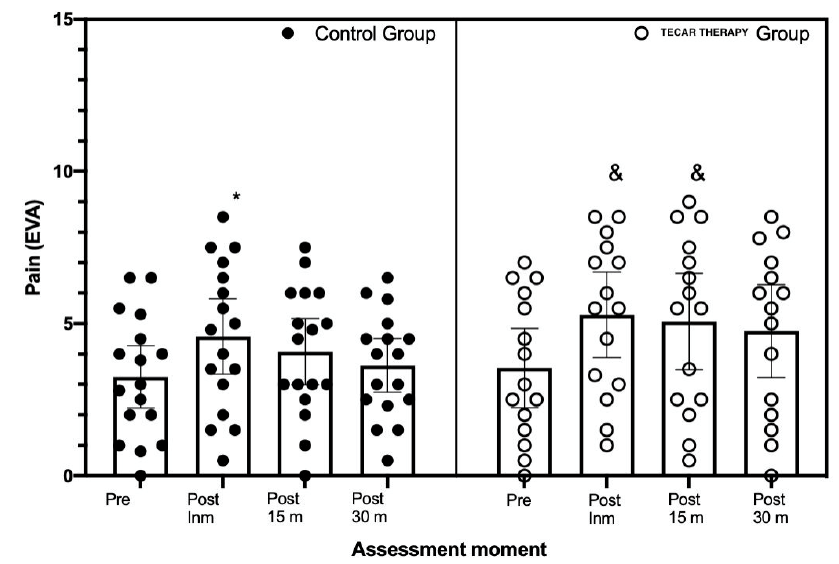
Figure 7. Mean, minimum, and maximum values of muscle temperature (°C) in the two intervention groups in relation to the measurements taken (i.e., Pre, post-immediate, post-15 min, and post-30 min). Note: * significant differences ( p < 0.05) compared to the pre series in the tecar therapy group. # Number of significant differences ( p < 0.05) compared to the pre series in the Control Group, & and significant differences ( p < 0.05) in the Control Group and tecar therapy group comparison. The lines represent the mean value and 95% confidence intervals. Prepared by the authors. (Pre: pre intervention; Post INM: post immediately; P15: after 15 min intervention; PI 30: after 30 min intervention).